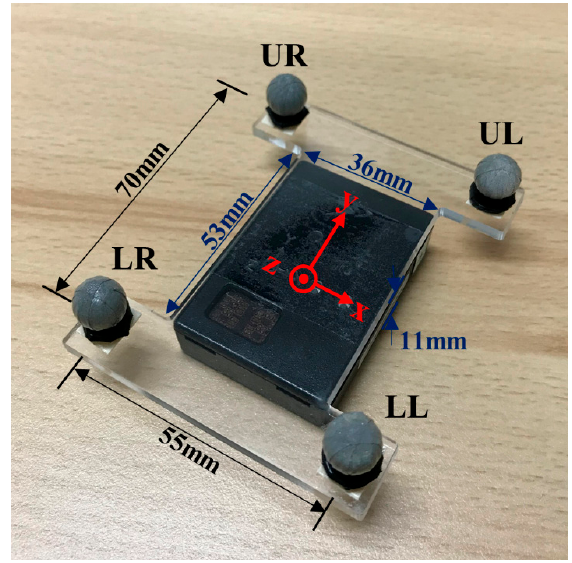
Figure 3. Acrylic plate attached on each IMU on the trunk segments. UR: upper right, UL: upper left, LR: lower right, LL: lower left.